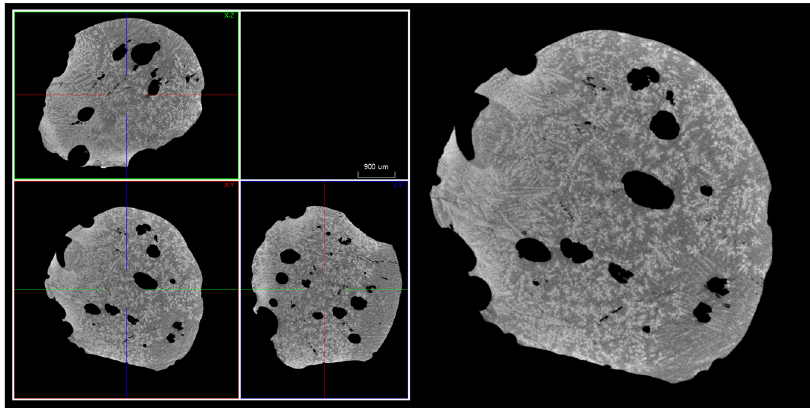
Fig. 4 Virtual cut of the iron silicide spherule. The spherule shown in Fig. 3 has evidence of melting and recrystallization structures.